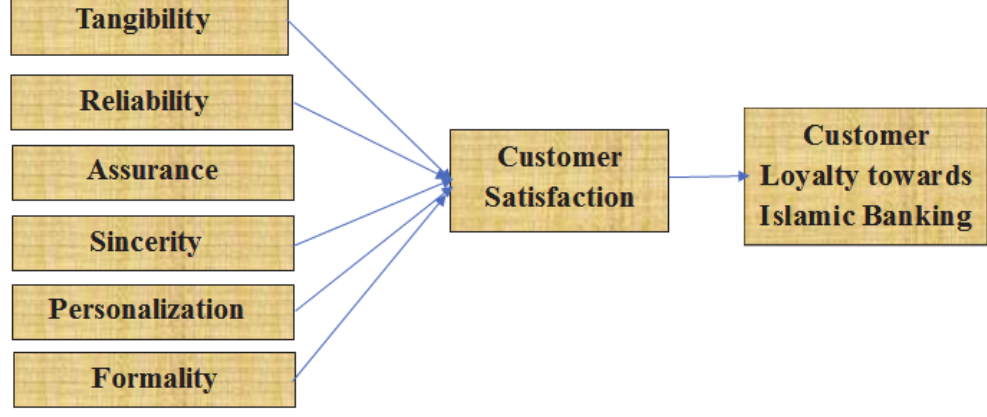
Fig. 1. Theoretical